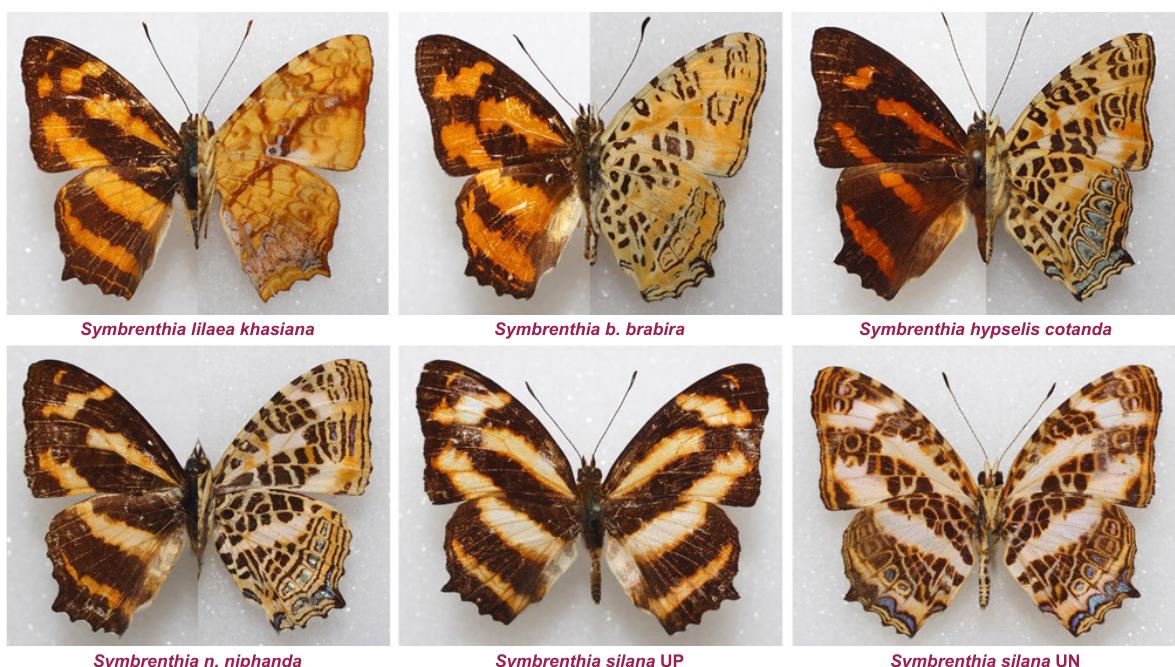
Image 1. Species of Indian Symbrenthia . Shown on the left are dorsal and on the right ventral wing surfaces for each specimen except S. silana , in which upper and under sides are illustrated separately. Sexes are similar. Identification key is given by Evans (1932). (Photographs: Krushnamegh Kunte; © President and Fellows of Harvard Male: Upperside black, forewing with a very regular streak from the base to beyond the cell extending slightly below the median but not touching the subcostal nervure,